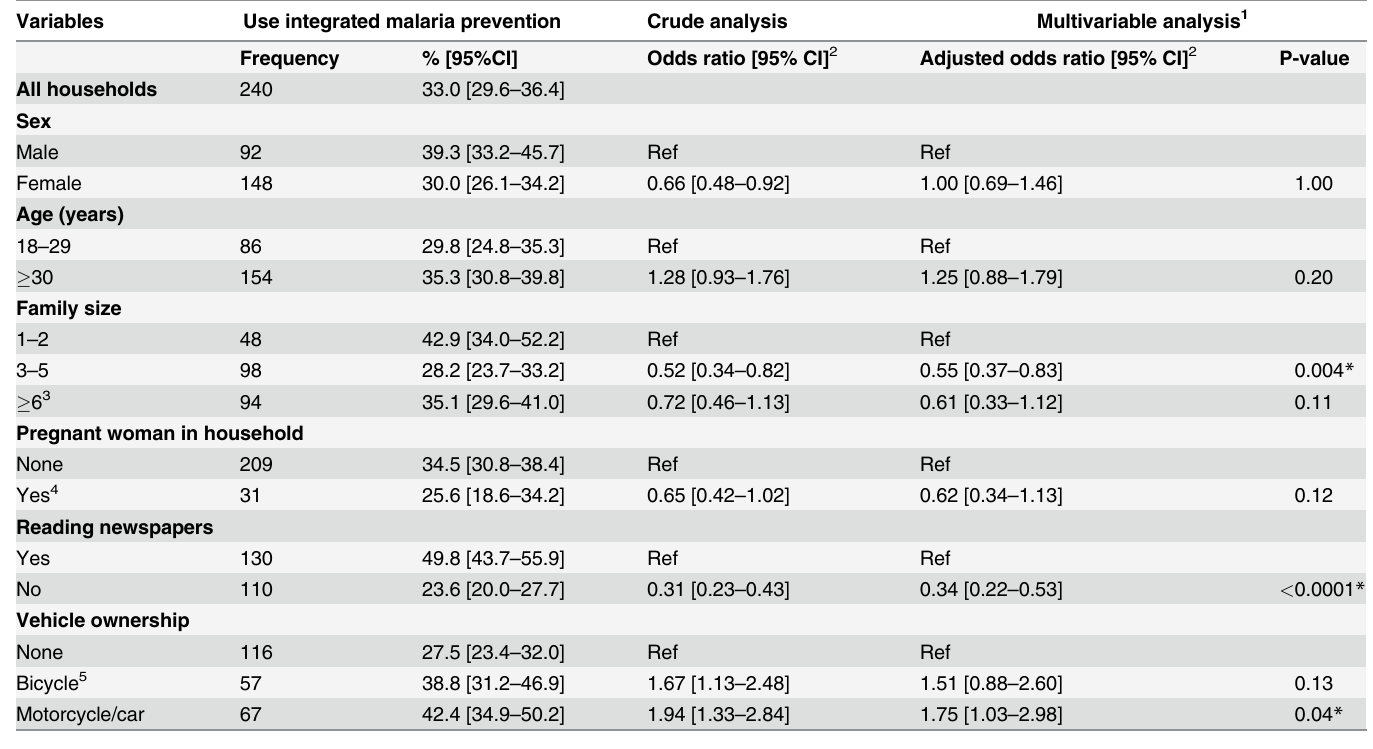
Table 4. Crude and multivariable analysis for use of integrated malaria prevention at